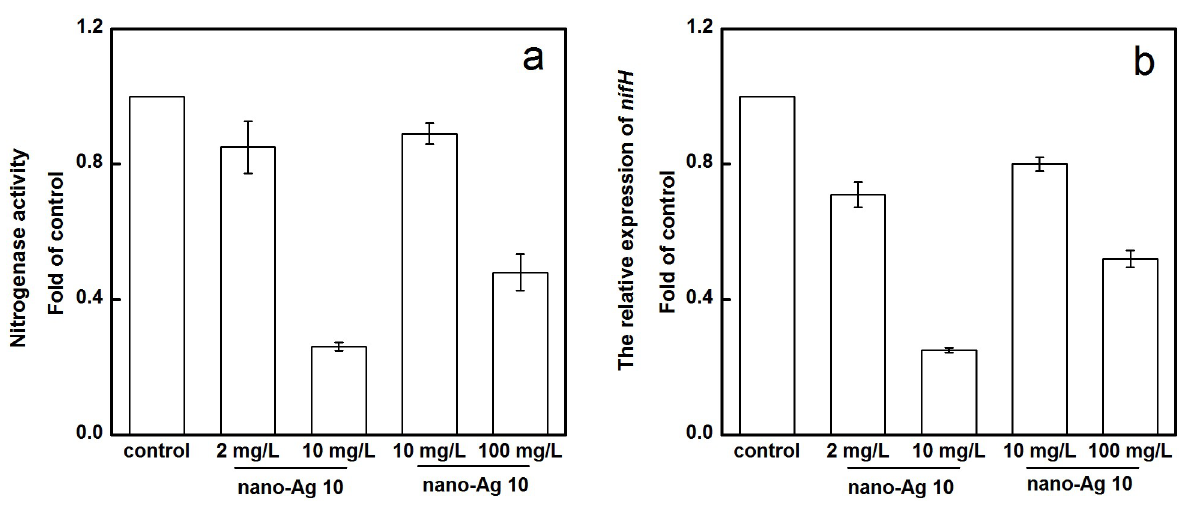
Fig 5. Nitrogenase activity (a) and relative expression of nifH (b) of A . vinelandii exposed to AgNPs for 12 h.